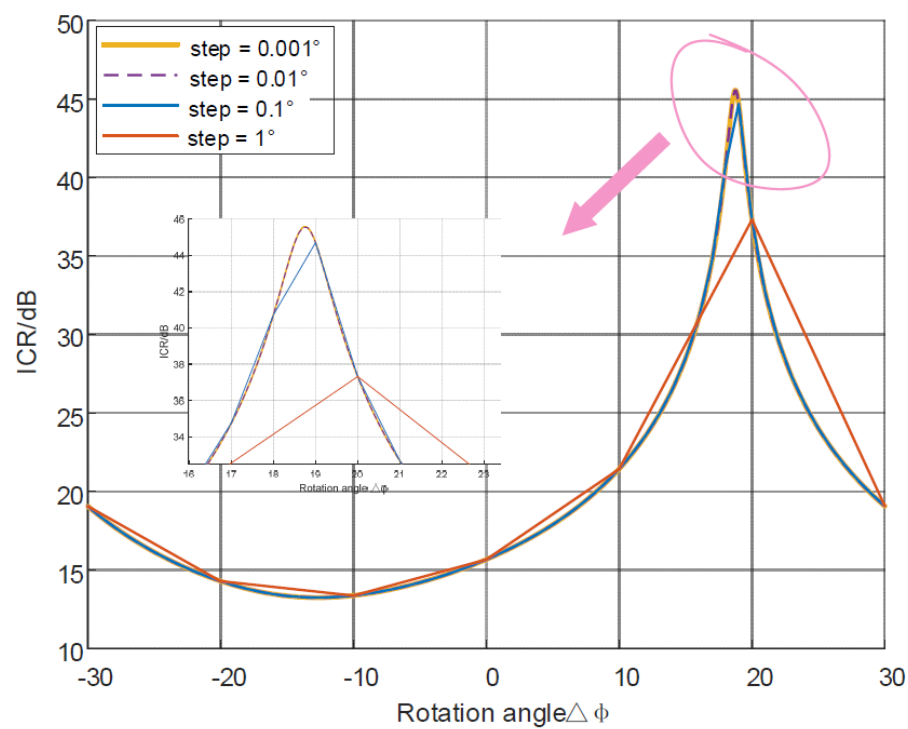
Figure 11. Relationship between traversal accuracy and search step size.